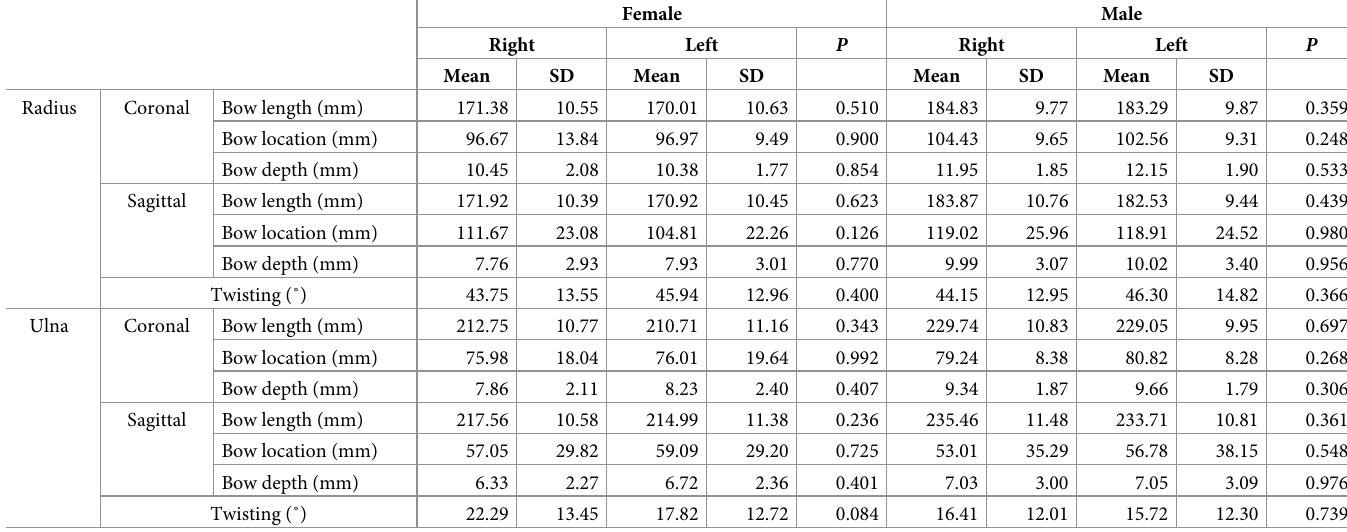
Table 3. Twisting and bending measurement of the forearm bones.